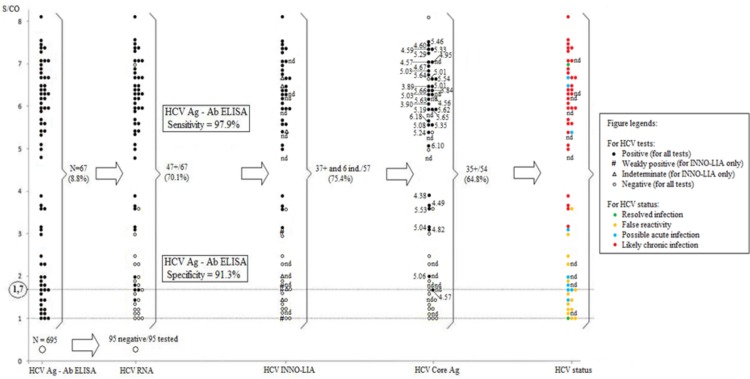
Results of HCV G4 ELISA, qualitative in-house HCV RNA RT-PCR, INNO-LIA and HCV core Ag in 762 HIV-co-infected patients from Franceville, Gabon (2010–2013).Concentrations of HCV core Ag are expressed in log10 IU/l. Abbreviations: nt, not done.